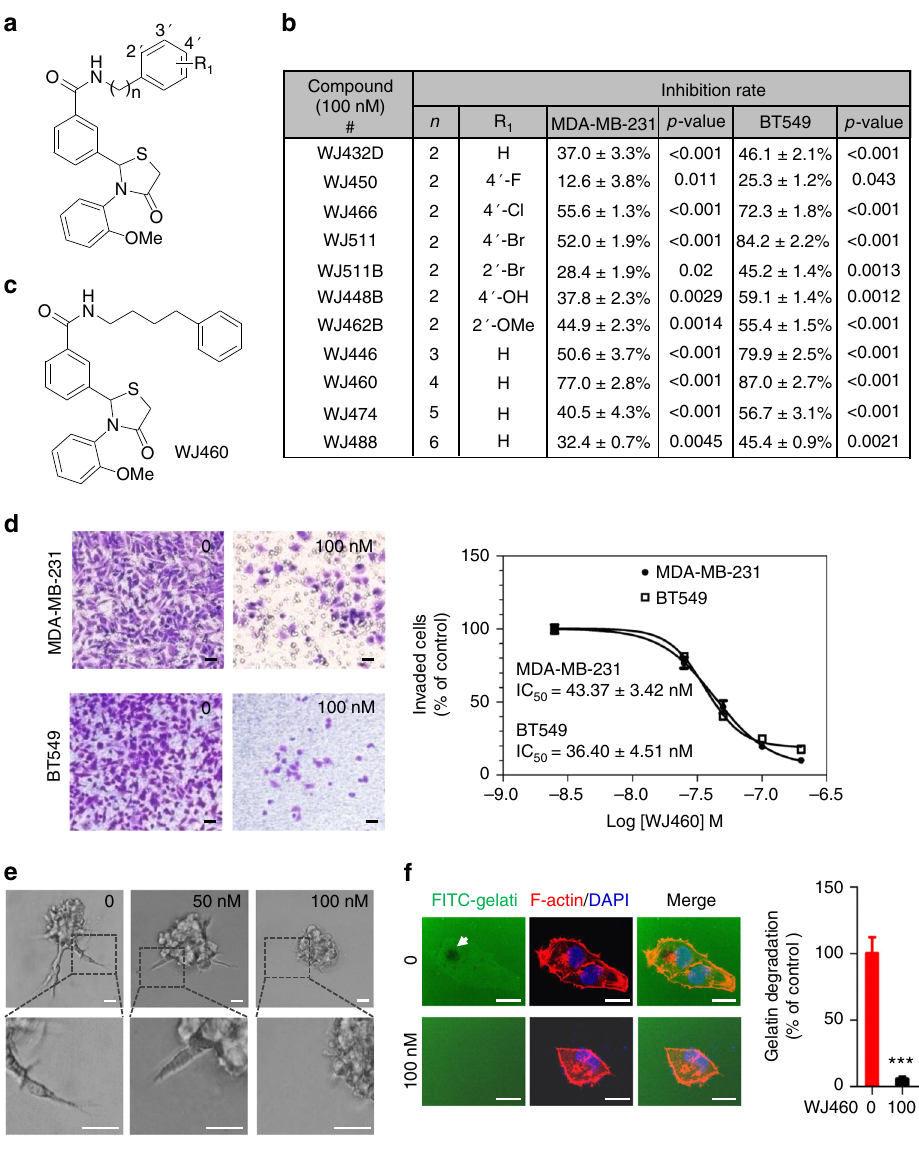
Fig. 1 WJ460 inhibits breast cancer invasion in vitro. a Chemical structure of thiazolidinone derivative family. b Structure – activity relationship for thiazolidinone derivative analogs and inhibition rate on breast cancer cells ( n = 3). c Chemical structure of WJ460. d MDA-MB-231 and BT549 cells were re-suspended in serum-free medium containing increasing concentrations of WJ460 and seeded into each transwell insert precoated with 10% matrigel. After 12 h, invading cells were stained with 0.1% crystal violet. Images were acquired using an inverted microscope (Olympus), with WJ460 dosage noted in upper right of each photomicrograph. WJ460 inhibited MDA-MB-231 and B549 cells invasion with an IC 50 of 43.37 ± 3.42 nM and 36.40 ± 4.51 nM, respectively ( n = 3). Scale bars, 50 μ m. e 3D Matrigel invasion assay. MDA-MB-231 cells were plated above a layer of Matrigel and covered with growth medium containing 10% Matrigel and different concentrations of WJ460 ( n = 3). Arrows, stellate invasive structure. Scale bars, 20 μ m. f MDA-MB-231 cells were seeded on FITC-gelatin for 12 h. F-actin was stained with phalloidin (red) and nuclei with DAPI (blue). Areas of gelatin degradation appear as punctuate black areas beneath the cells. *** p < 0.001. Scale bars, 10 μ m. Student ’ s t test, n = 3. In b – f , n indicates the number of independent